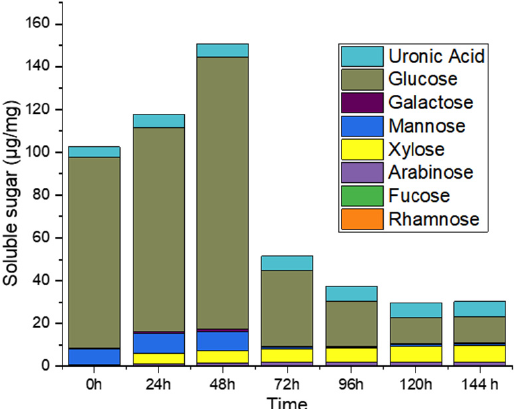
Figure 1. Monosaccharide soluble sugars compositions during the fermentation process. Results are expressed as µ g/mg anhydrous sugars in original sample.